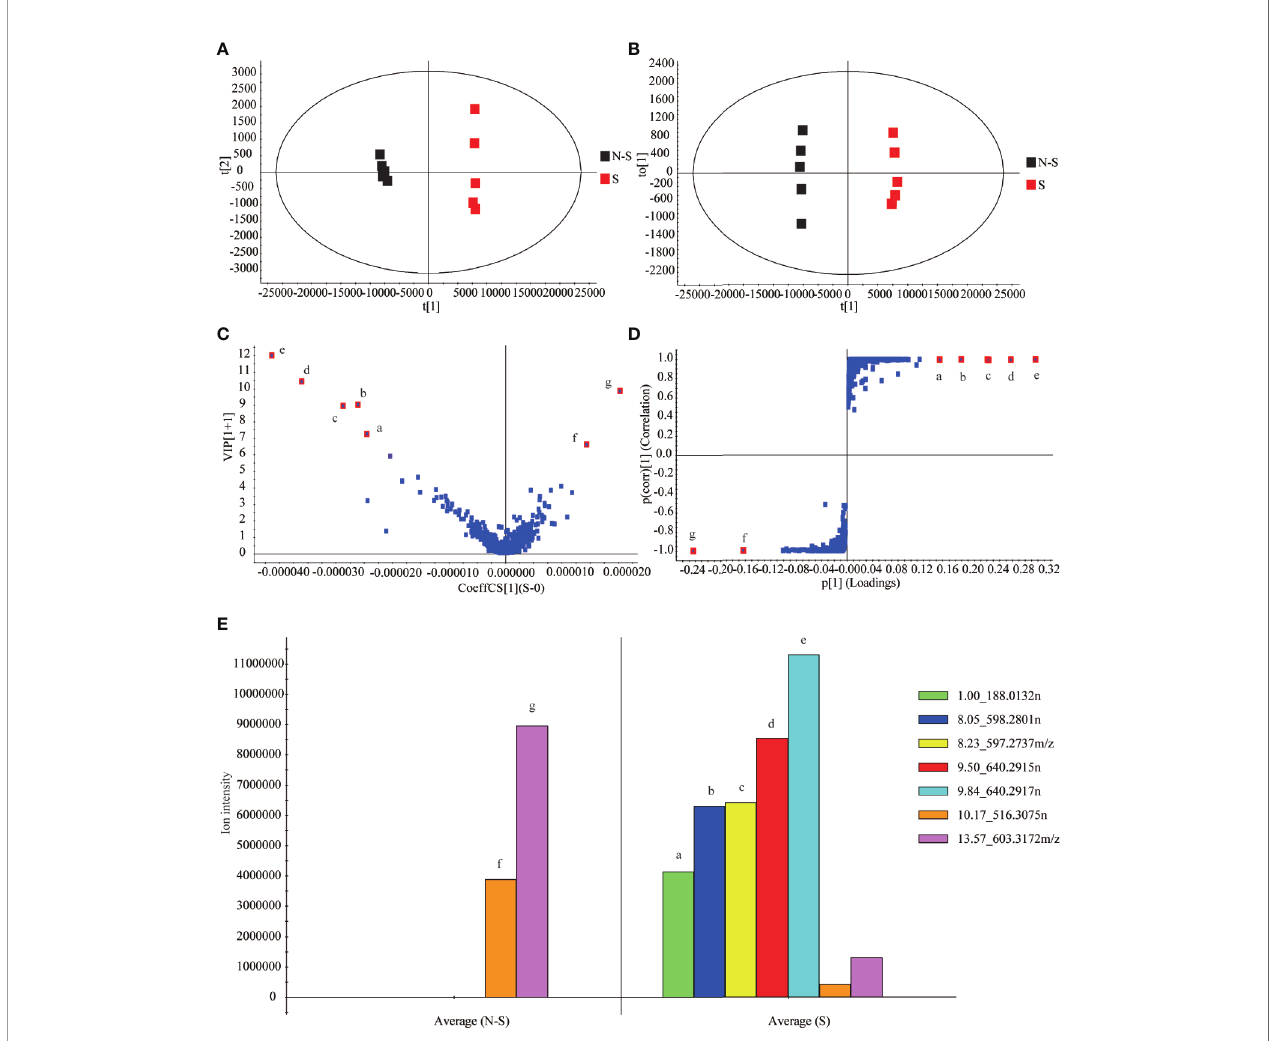
FIGURE 2 | Multivariate statistical analysis of methanol extracts of non-fumigated TR (0 h) and sulfur-fumigated GR (2 h) samples: (A) PCA/scores plot ( fi ve samples with each group, three biological replicates); (B) OPLS-DA/scores plot ( fi ve samples with each group, three biological replicates); (C) VIP plot; (D) S-plot; (E) column plot of the ion intensity (compounds a – g are signi fi cantly different markers in TR